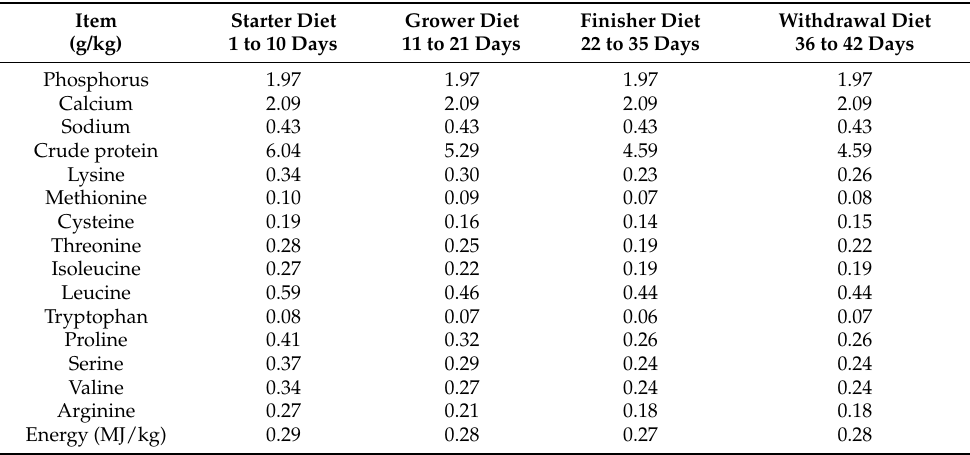
Table 4. Matrix values assigned to exogenous phytase (1000 FTU/kg) in Moss et al. [136]. Item